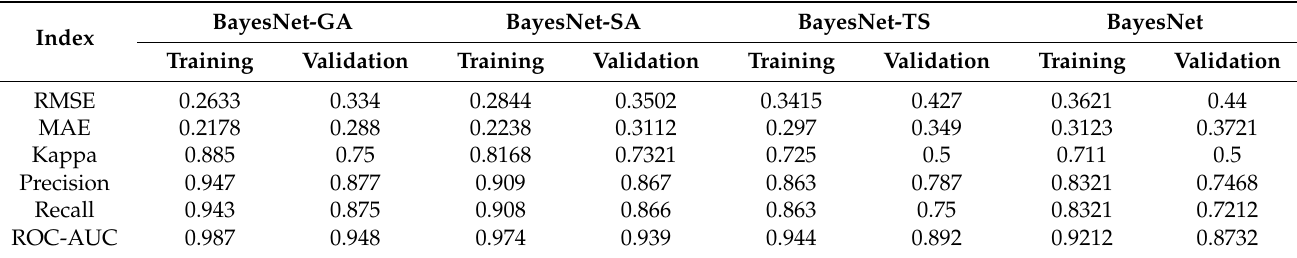
Table 3. Results for metric